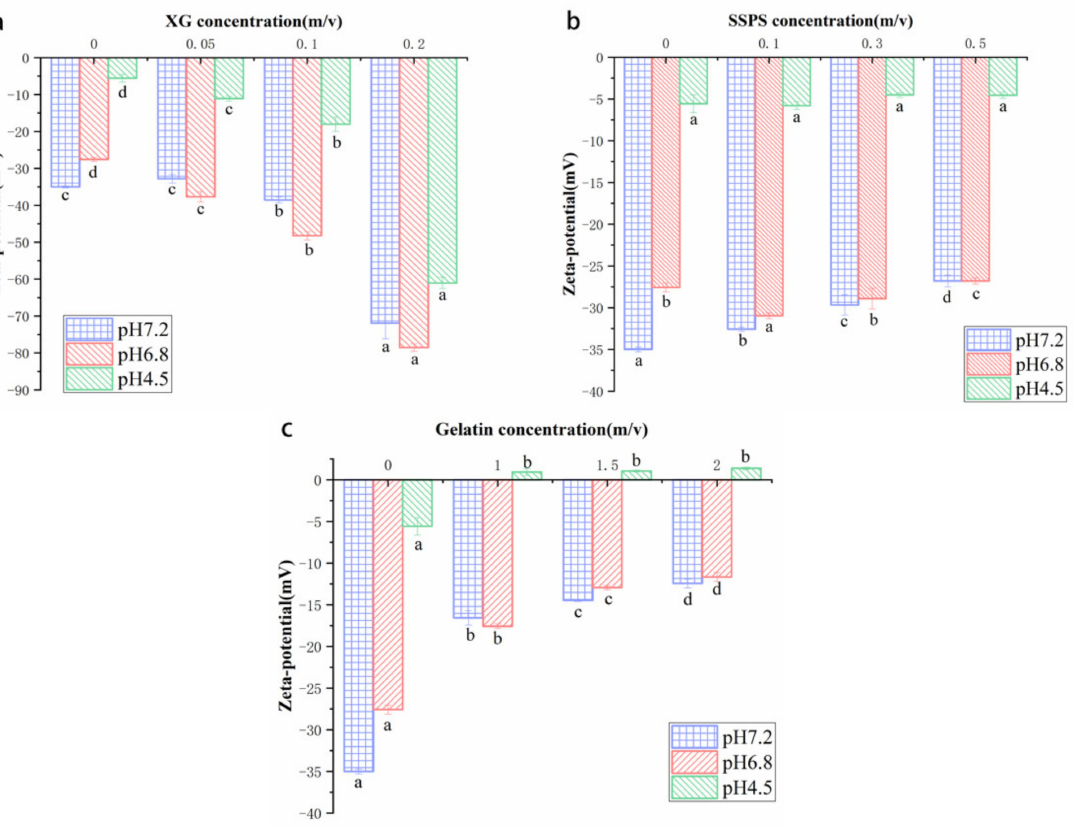
Figure 2. The zeta potential of CP-Hydrocolloid systems at different pH values and different con- centrations of the three hydrocolloids. The CP concentration was 1% ( w / v ). Letters a–d indicate significant difference in different pH ( p < 0.05). ( a ) CP-XG; ( b ) CP-SPSS; ( c ) CP-Gelatin. (CP-Coconut protein, XG-Xanthan gum, SSPS-Soluble soybean